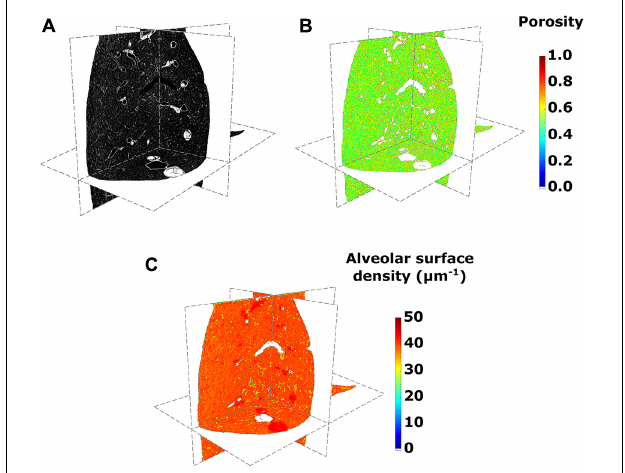
FIGURE 3 | (A) Micro-computed tomography (CT) images of a lung in its axial, sagittal, and coronal views, (B) porosity, and (C) alveolar surface density maps for the SAF-HMDS group in the different anatomical